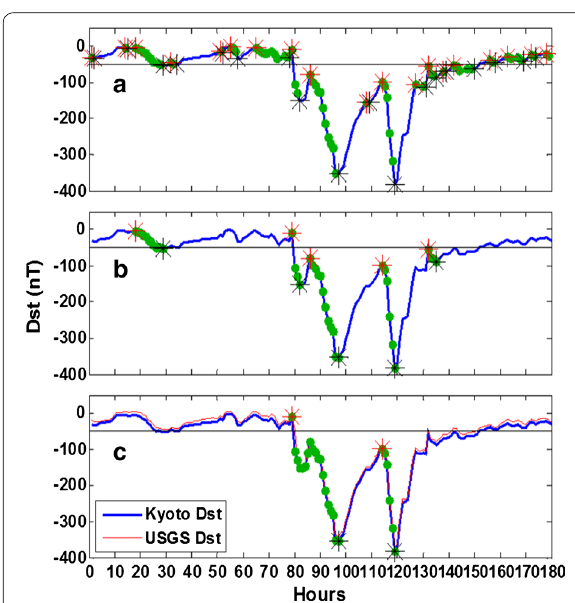
Fig. 2 Examples of Dst data (in December 1958 and August 1960) showing moderate ( a ) and intense ( b ) storms identified in Kyoto Dst ( blue ) but not in USGS Dst ( red